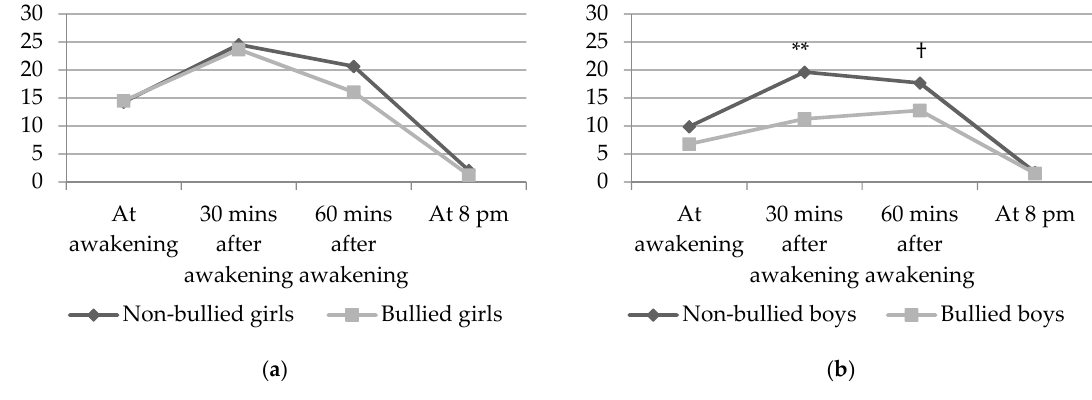
Figure 1. ( a ) Diurnal salivary cortisol output (nmol/L) at four time points during one day among non-bullied and bullied girls. n = 131. ( b ) Diurnal salivary cortisol output (nmol/L) at four time points during one day among non-bullied and bullied boys. n = 60. ** p < 0.01 † p < 0.10.